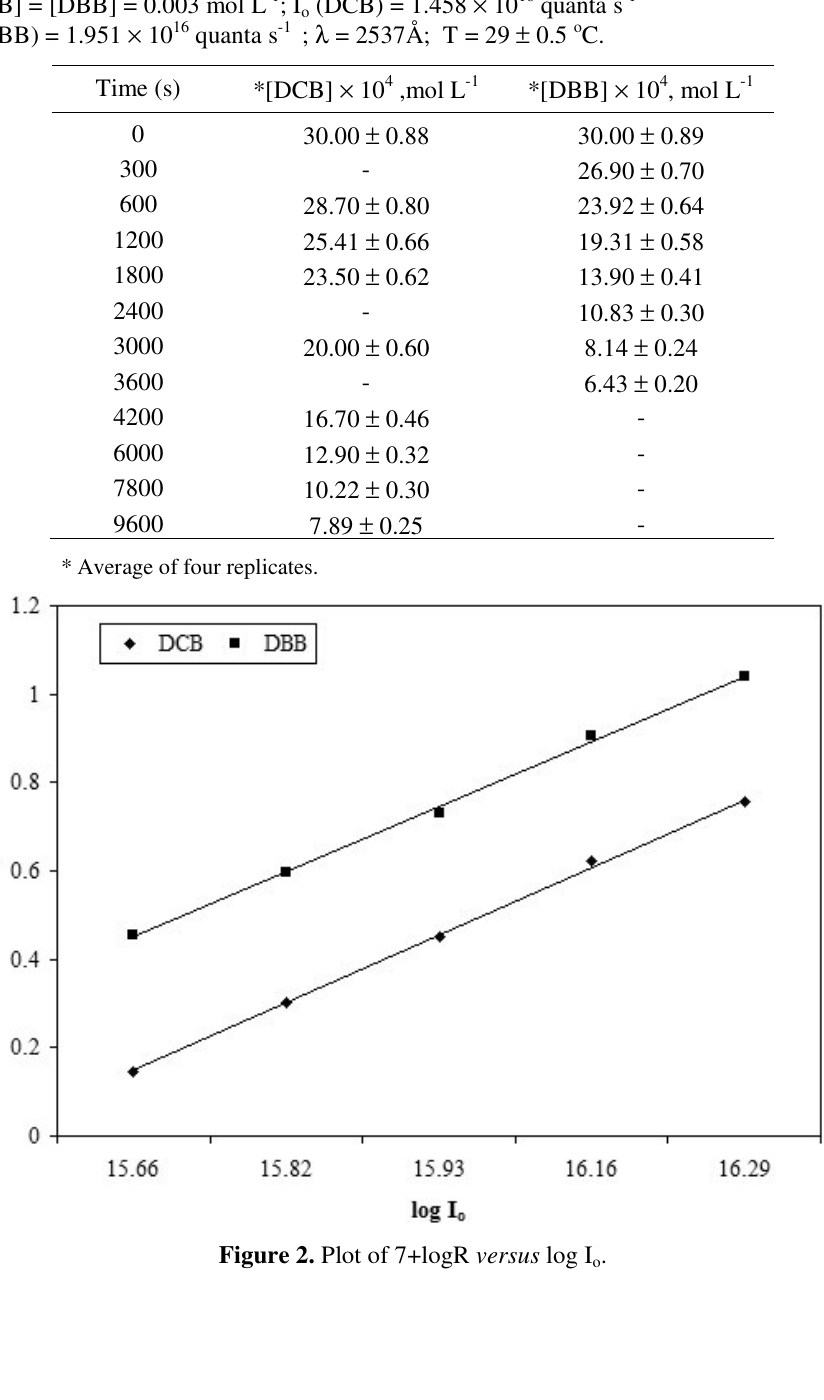
Table 1. Photodecomposition of DCB and DBB in aqueous acetic acid solution with time